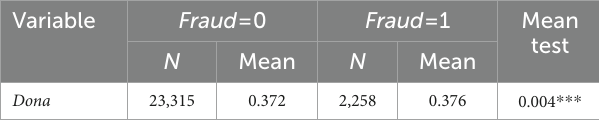
TABLE 3 Single variable